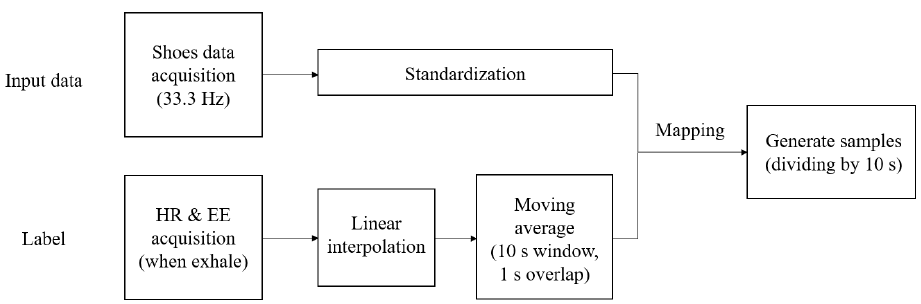
Figure 4. Flowchart of the data preprocessing when training the proposed deep learning model. The input shoes’ data were recorded at a 33.3 Hz sampling rate and standardized to have a zero mean and unit variance. The label was created based on the HR and EE information, which were averaged on a 10 s long window with an overlap of 1 s.